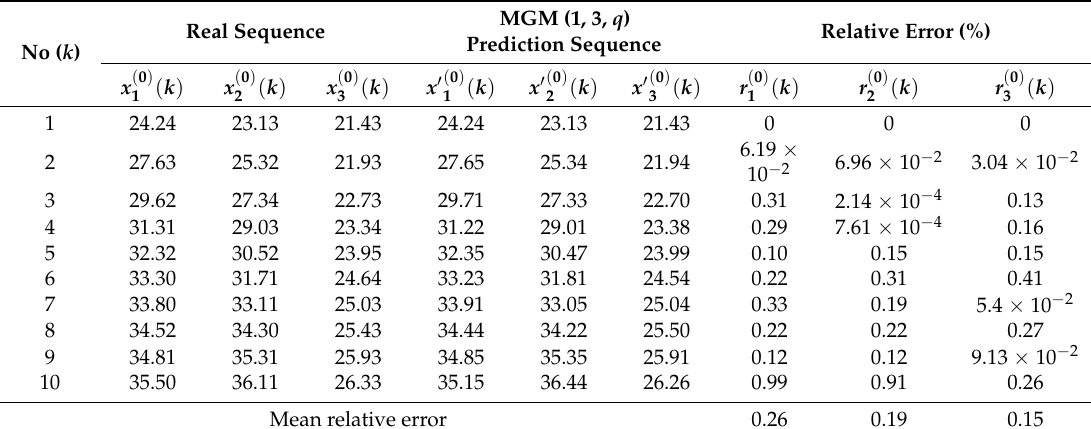
Table 1. MGM (1, 3, q ) model fitting value and error analysis.